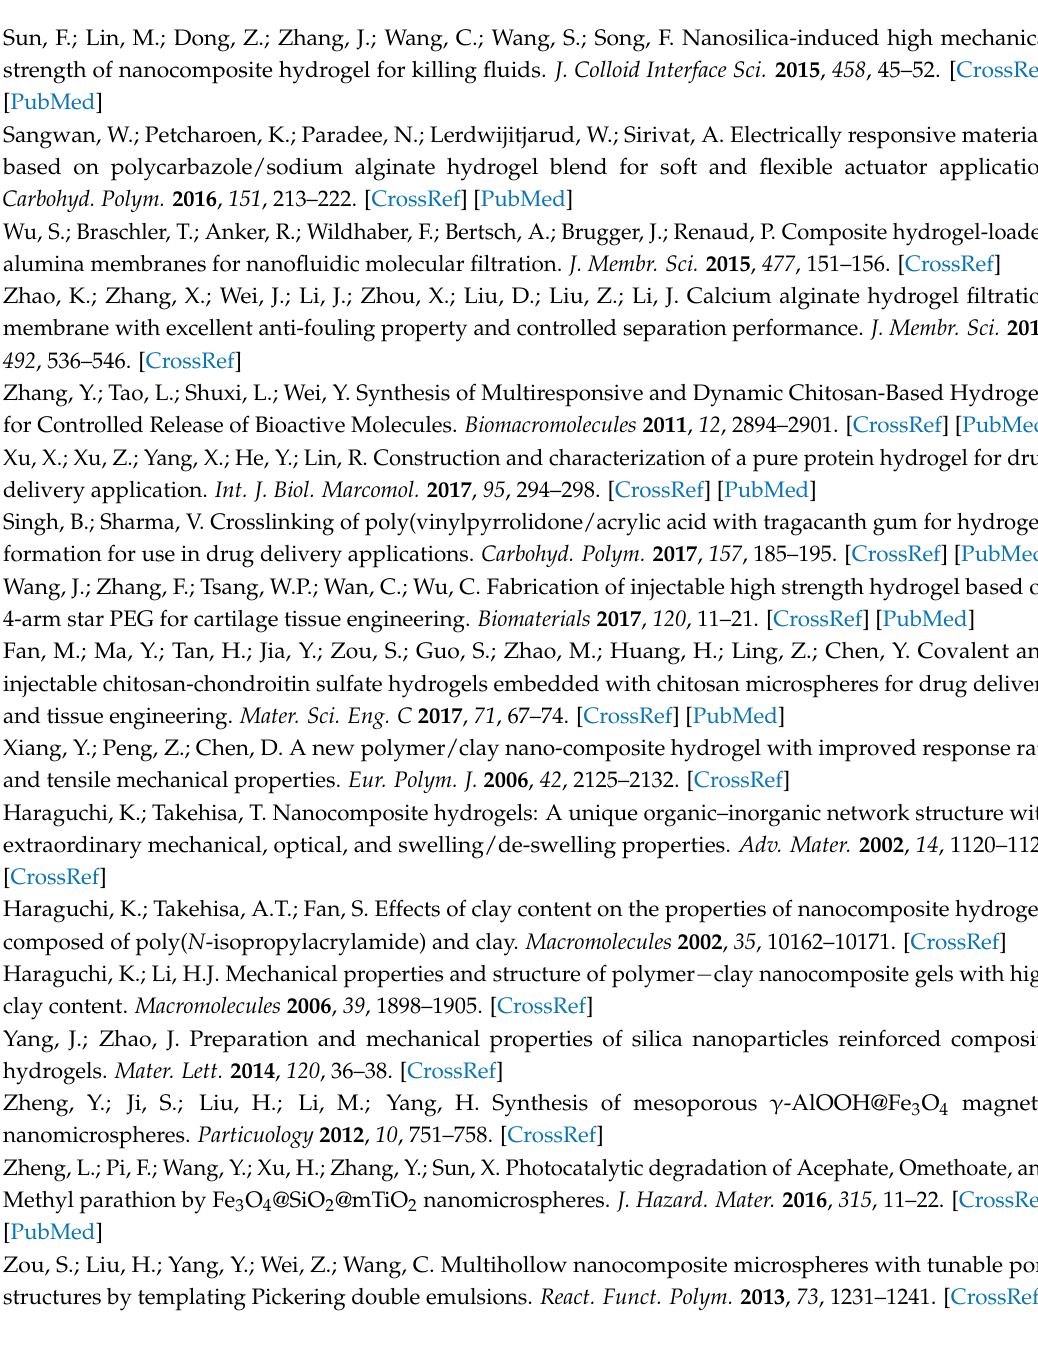
Figure S1: SEM images of acrylamide (AM)/2-hydroxyethyl methylacrylate (HEMA) microspheres (a) ordinary polymeric microspheres; (b) polymerizable microspheres, Figure S2: FT-IR spectra of polymer (a) polymerizable AM/HEMA microspheres; (b) hydrogel containing polymerizable microspheres, Figure S3: 13 C NMR spectrum of polymer (a) polymerizable AM/HEMA microspheres; (b) hydrogel containing polymerizable